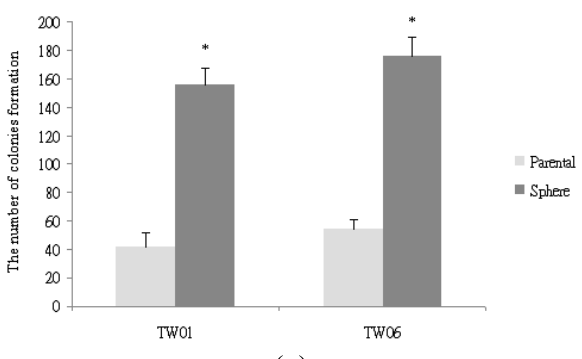
Figure 1. Characterization of NPC sphere-derived cells cultured